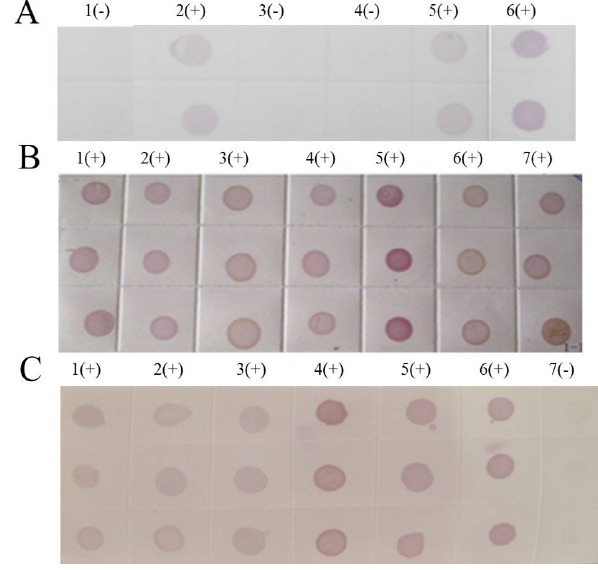
Figure 11. Results in three county laboratories. (A) Libo of Guizhou province. 1(-): Negative control (stem tissue). 2(+) - 5(+): Suspected samples. 6(+): Positive control. (B) Shidian of Yunnan province. 1(+) - 6(+): Suspected samples collected from Shidian in Yunan province. 7(+): Positive control. (C) Jianghua of Hunan province. 1(+) - 5(+): Suspected samples. 6(+): Positive control. 7(-): Negative control (stem